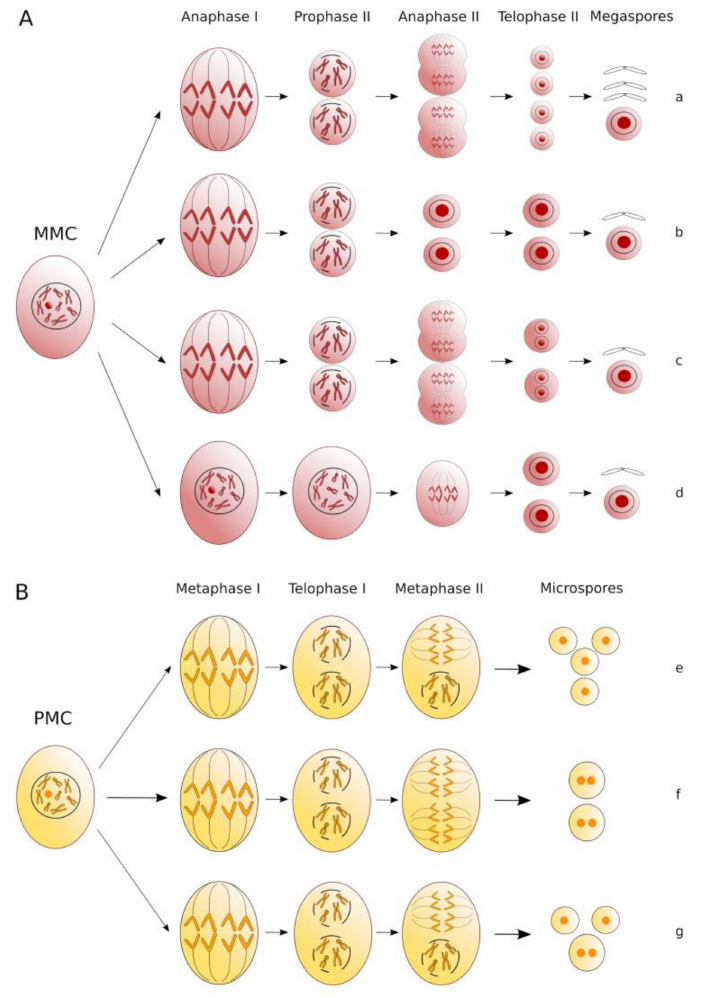
Figure 1. Schematic representation of the main defects of macro- ( A ) and microsporogenesis ( B ) pro- cesses that lead to 2 n spore formation in alfalfa. Normal megasporogenesis producing a functional n megaspore ( a ); absence of the second meiotic division ( b ) and failed cytokinesis after telophase II ( c ) responsible for the 2 n SDR megaspores; omission of reductional division followed by equational cen- tromeric division that leads to FDR-type 2 n megaspore production through diplosporic apomeiosis ( d ). Normal microsporogenesis resulting in a tetrad of n microspores ( e ); incorrect spindle orientation at metaphase II leading to two 2 n microspores ( f ); null cytokinesis after telophase II responsible for the formation of a triad of one 2 n and two n microspores ( g ) (this figure has been modified and adapted from